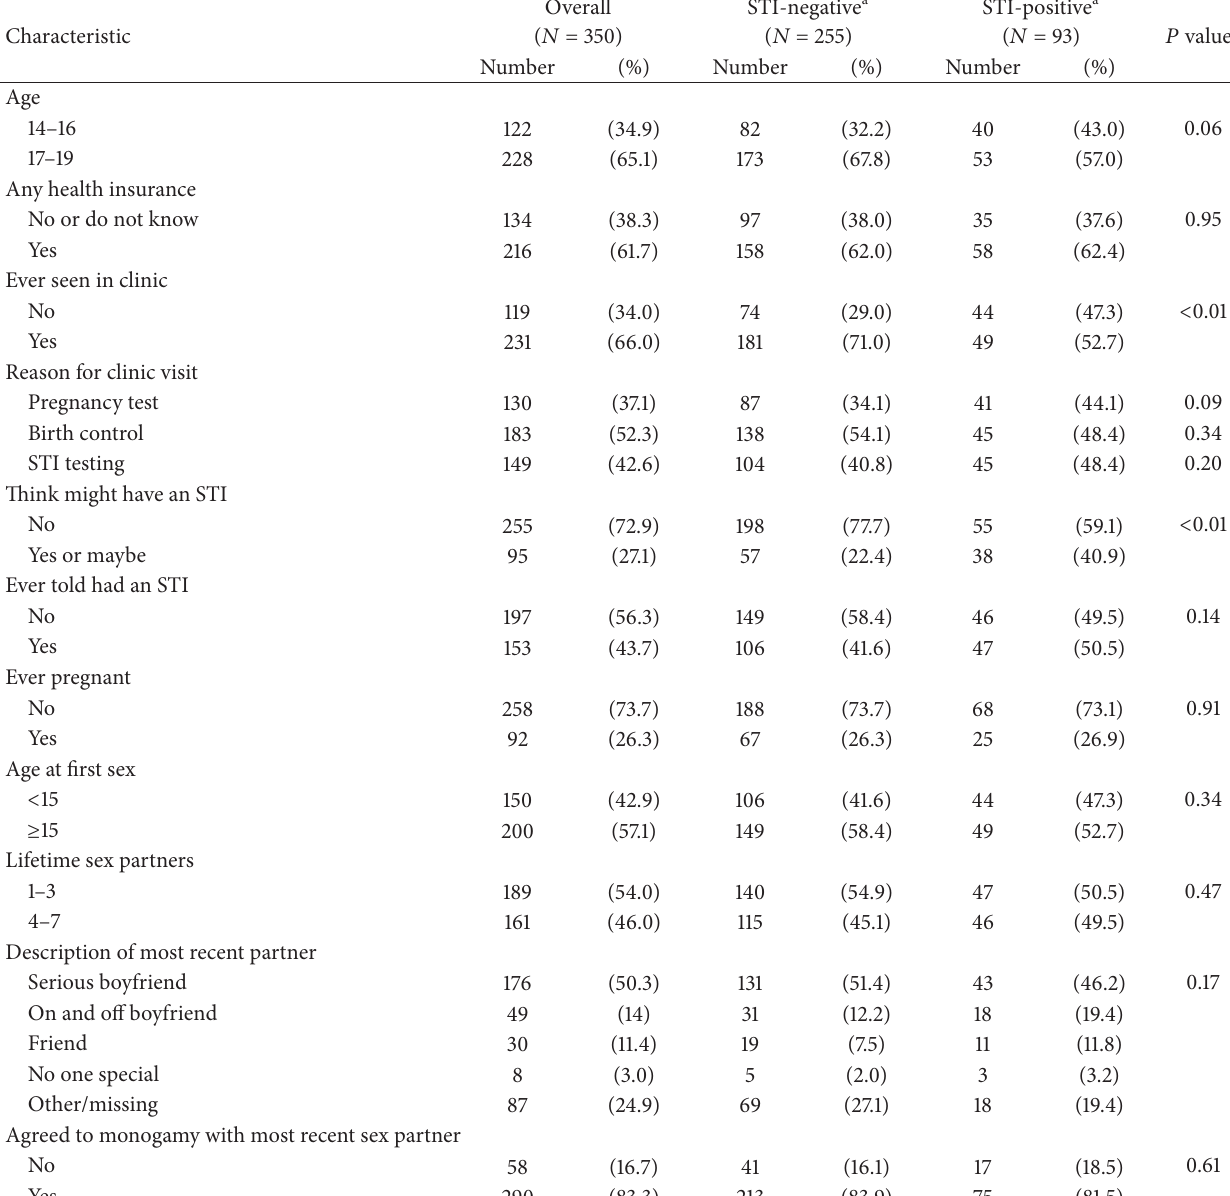
Table 1: Baseline demographic, reproductive history and behavioral characteristics, overall and by sexually transmitted infection status at